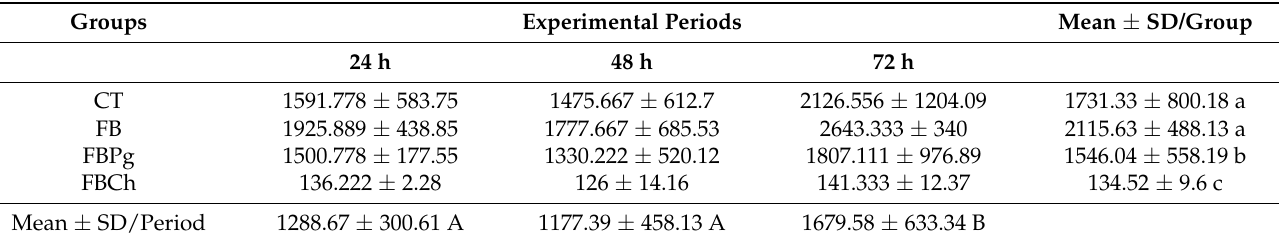
Table 4. Average absorbance values (nm) ± standard deviations (SD) of the metabolic activity of the C. albicans biofilm for the adhesives tested on specimens made with CAD-CAM resin.